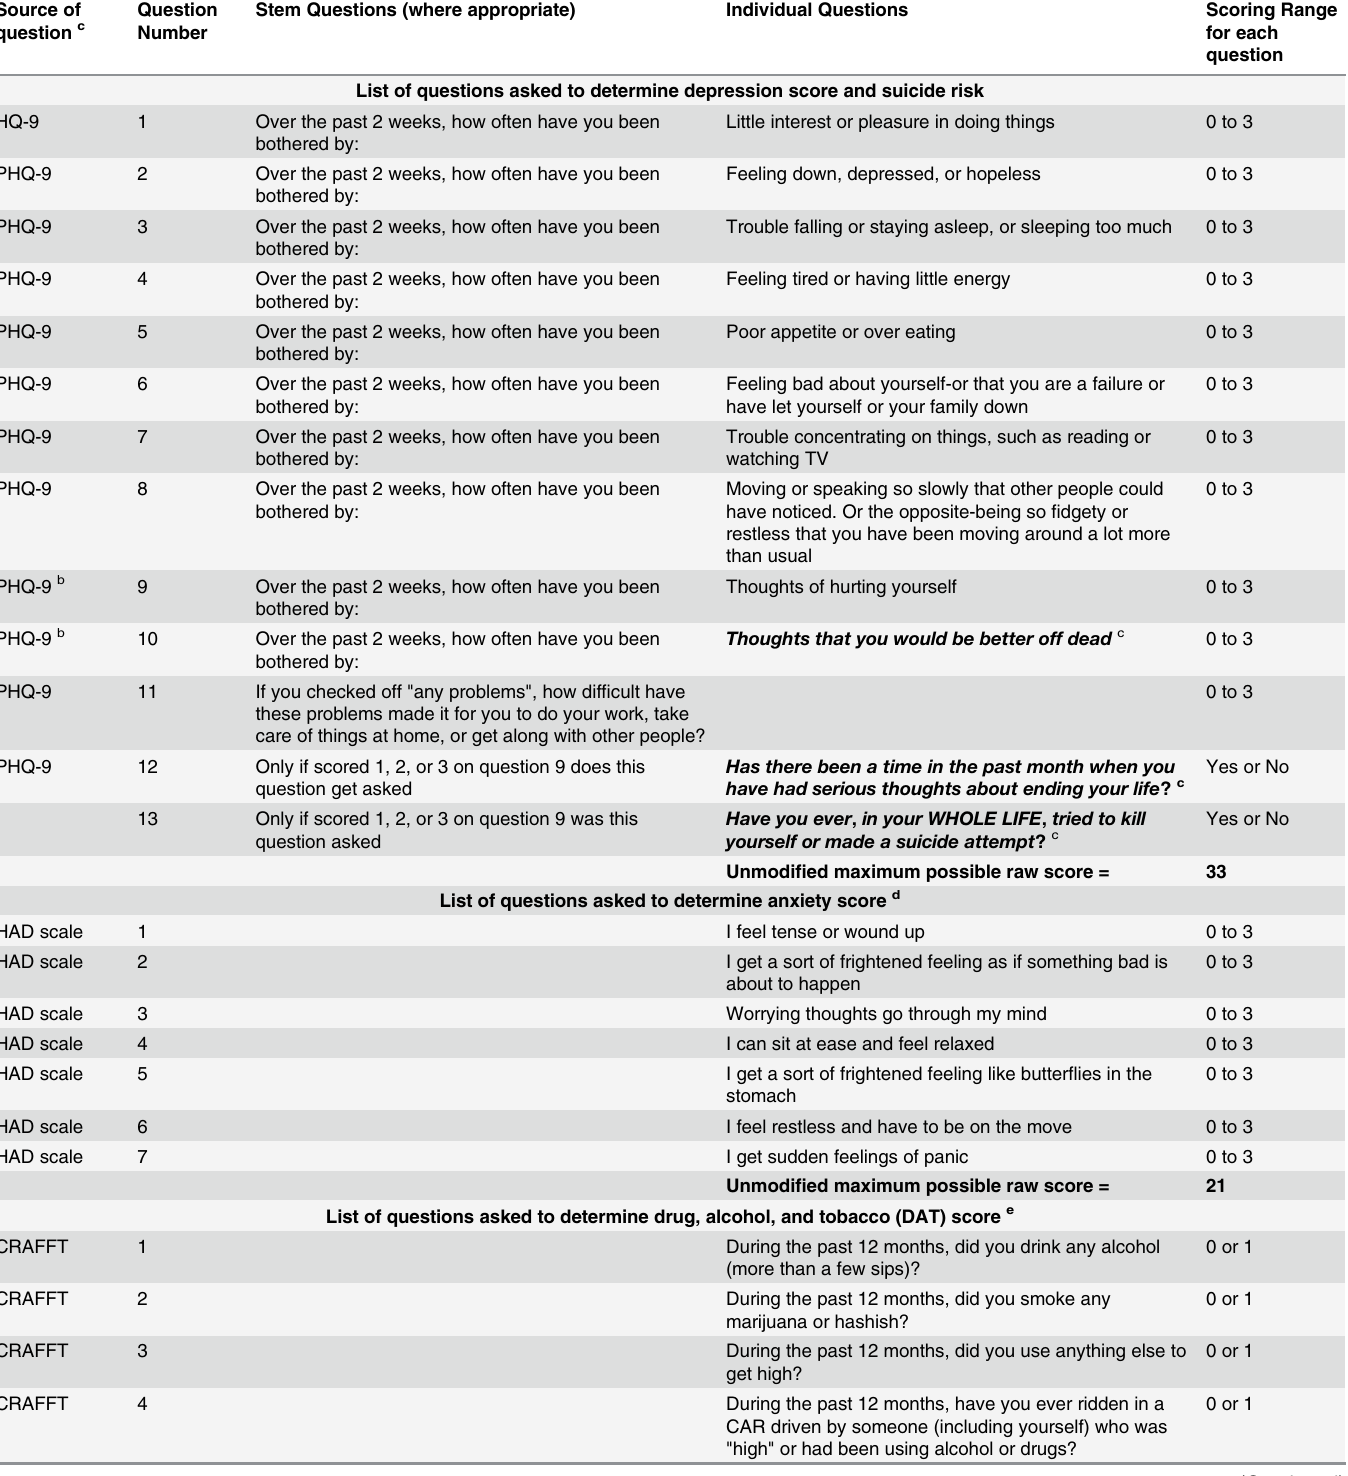
Table 2. List of questions asked. Source of question